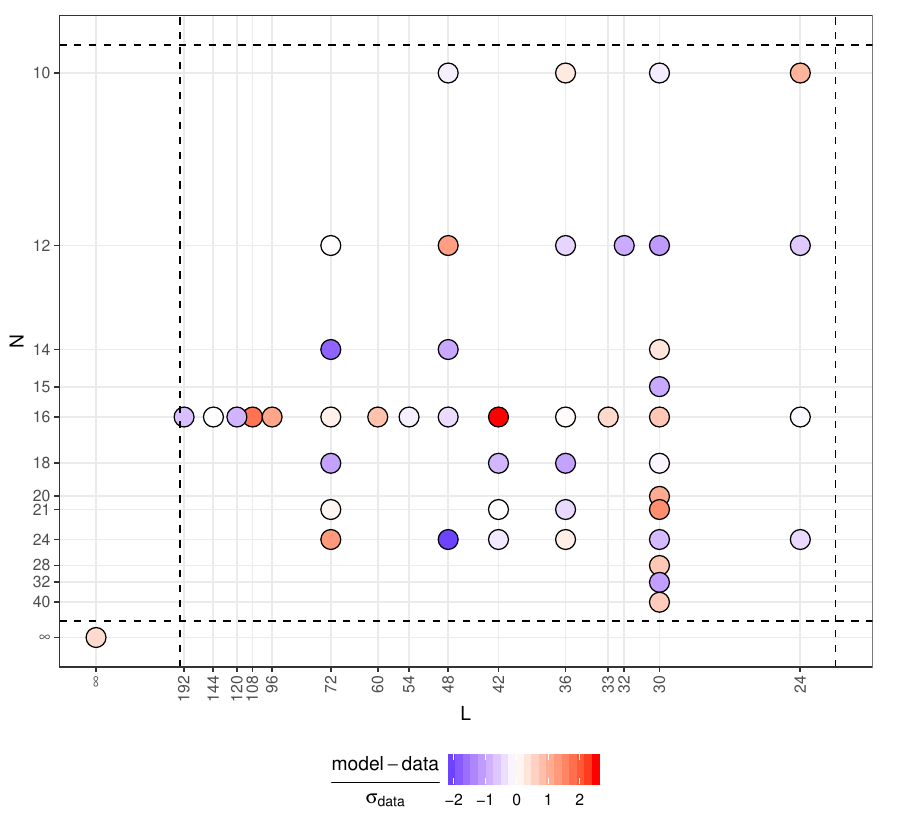
Figure 12 . Simultaneous large- N and continuum extrapolation of the energy at T = 0 . 3 , µ = 0 . 5 using the ansatz (5.2). Datapoints within the dashed lines are included in the fit. Fitting results are summarized in table 2. The colored circles in the figure encode the normalized deviation of the measurements from the fit. The absence of localized clusters of over- or underestimations provides a first indication of the suitability of the fitting ansatz. A quantitative statistical test is presented in figure 13. The large N continuum result is compared to the gravity prediction including estimates of a 1 , a 2 from